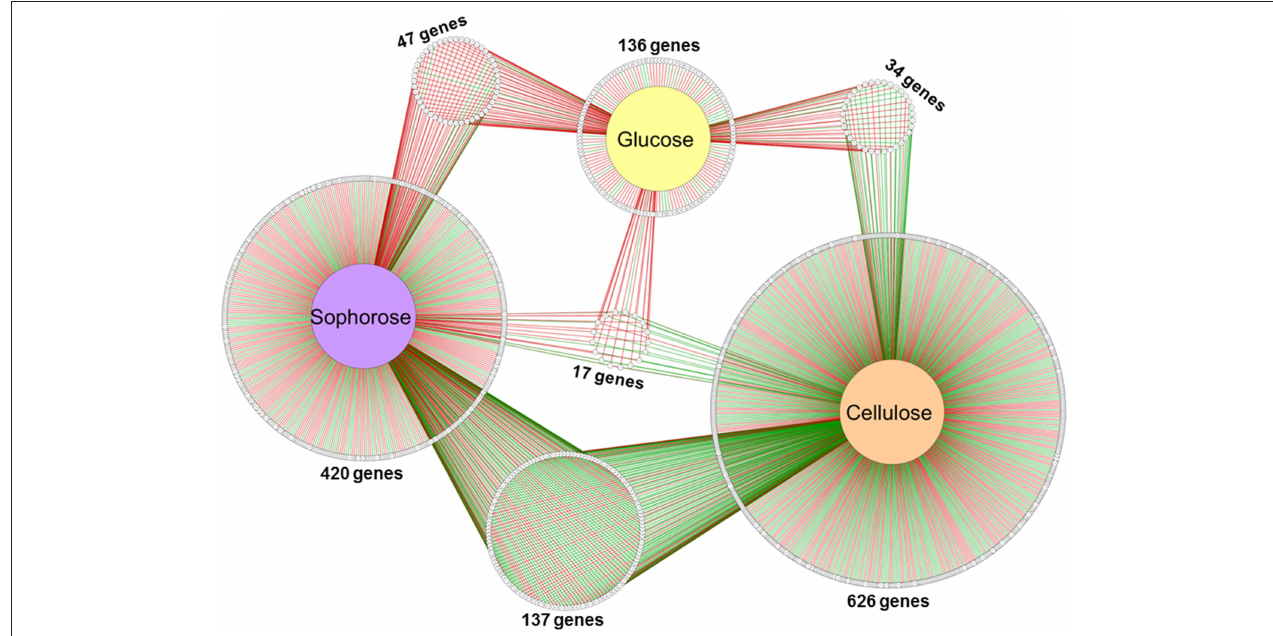
FIGURE 2 | Gene Regulatory Network (GRN) of 1184 differentially expressed genes in ∆ xyr1 /QM9414 in response to different carbon sources (cellulose, sophorose, and glucose). Genes are represented as nodes (shown as circles), and interactions are represented as edges (red lines: up-regulated interactions; and green lines: down-regulated interactions), connecting the nodes: 1674